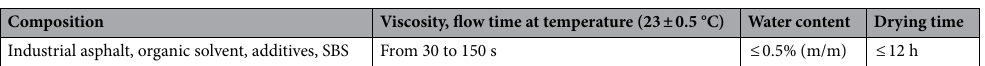
Table 3. Technical data of the commercial solvent-based coating.